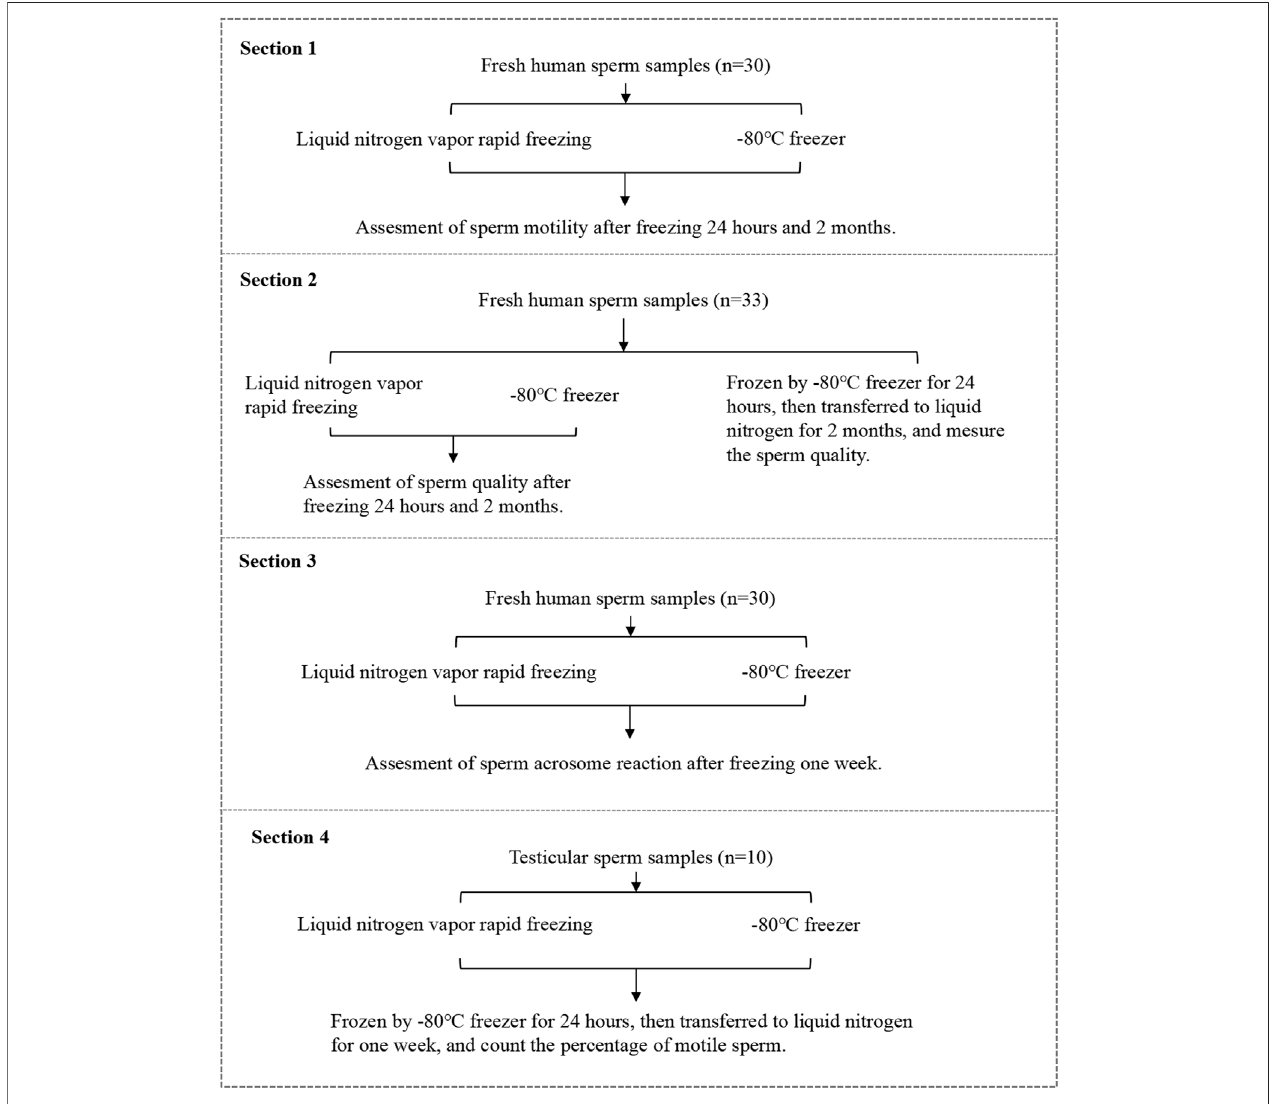
FIGURE 1 | Diagrammatic representation of the experimental